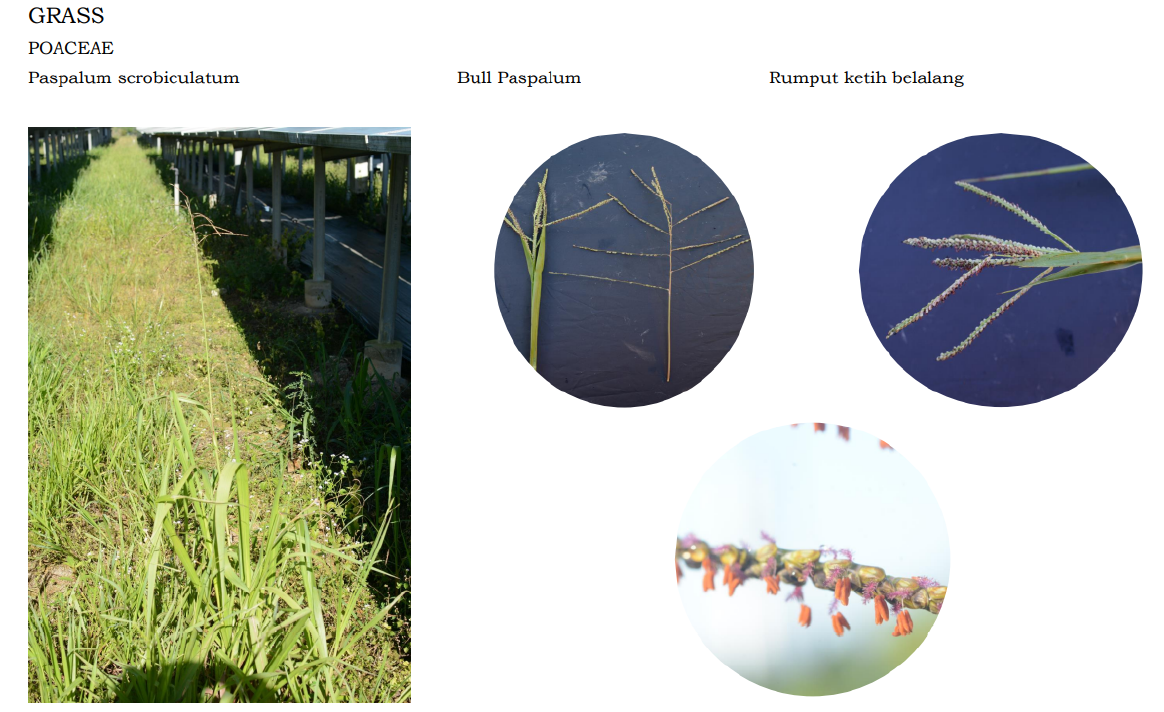
Figure A6. Grass Poaceae: Paspalum scrobiculatum.